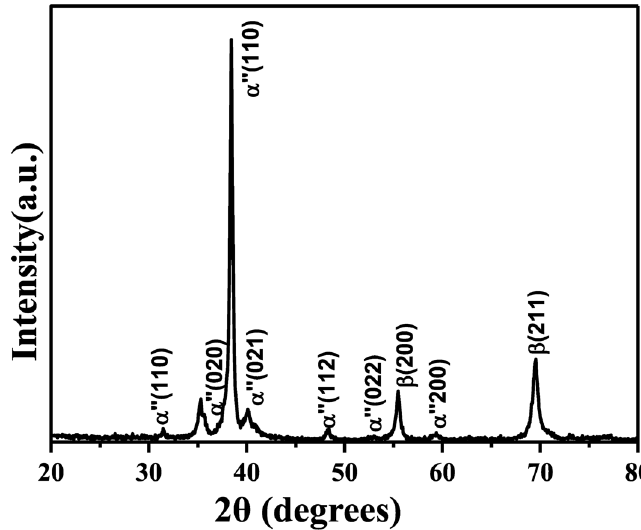
Figure 2. X-ray diffraction pattern of the titanium and tantalum alloy.